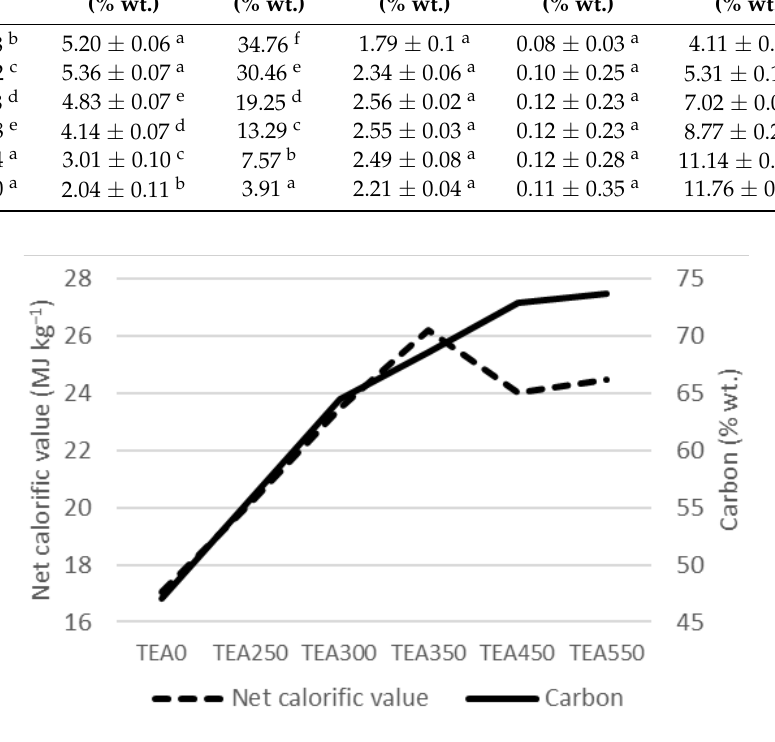
Figure 1. Carbon and net calorific value mutual influence.